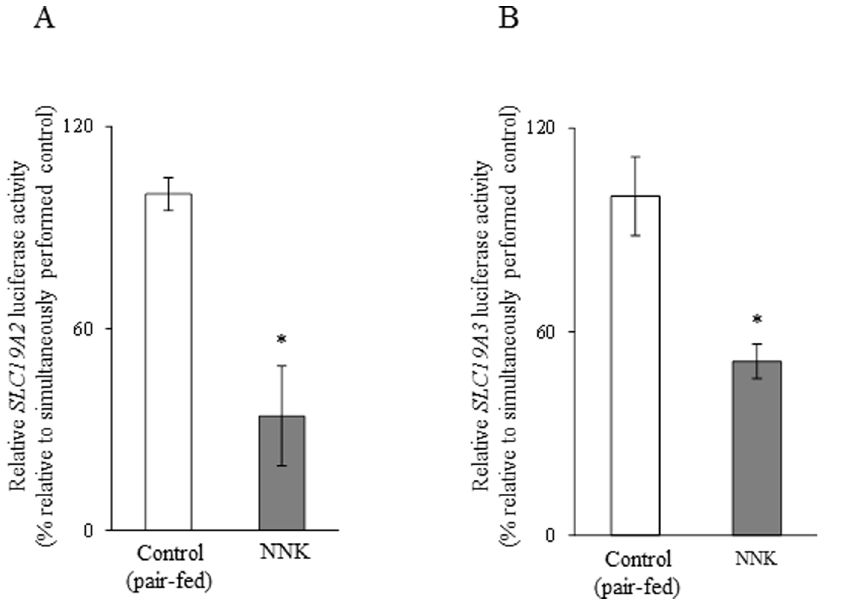
Figure 8. Effect of chronic exposure of transgenic mice carrying SLC19A2 and SLC19A3 promoters to NNK on the activity of these promoters. The activity of SLC19A2 (A) and SLC19A3 (B) promoters were determined as described in ‘‘Materials and Methods’’ and are presented as percentage relative to pair-fed controls. Data are mean 6 SE of at least 3 independent experiments from multiple sets of mice. * P , 0.01.